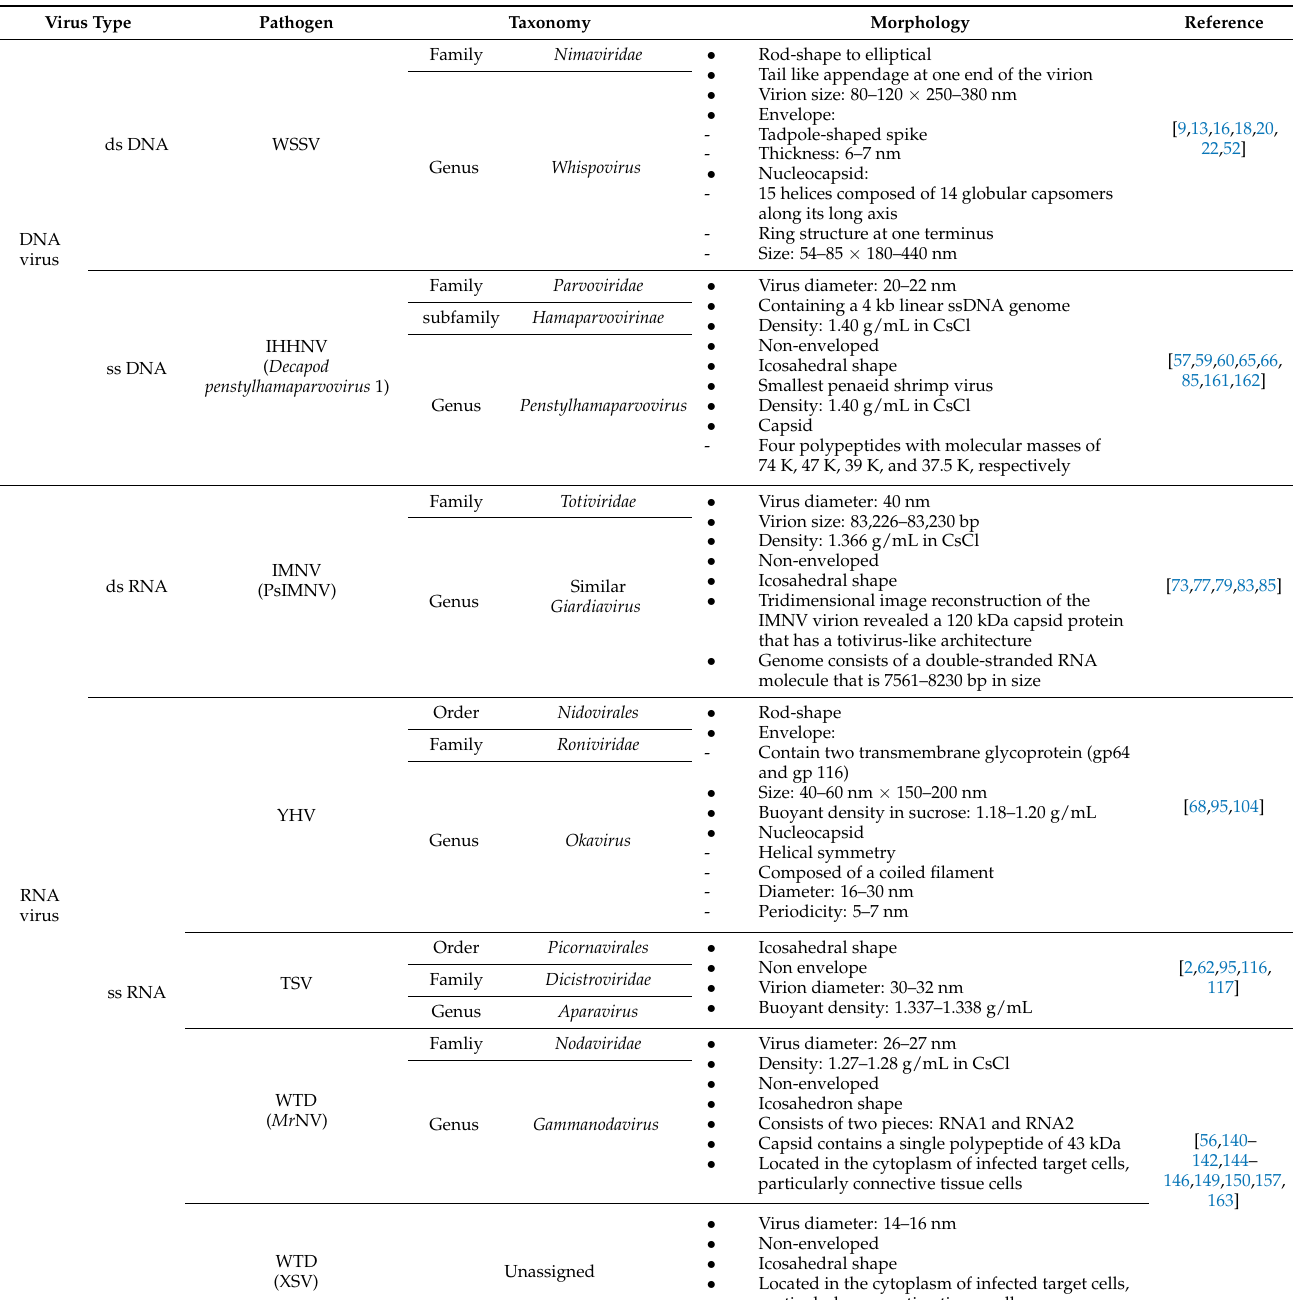
Table 1. Summary information for DNA and RNA viral diseases